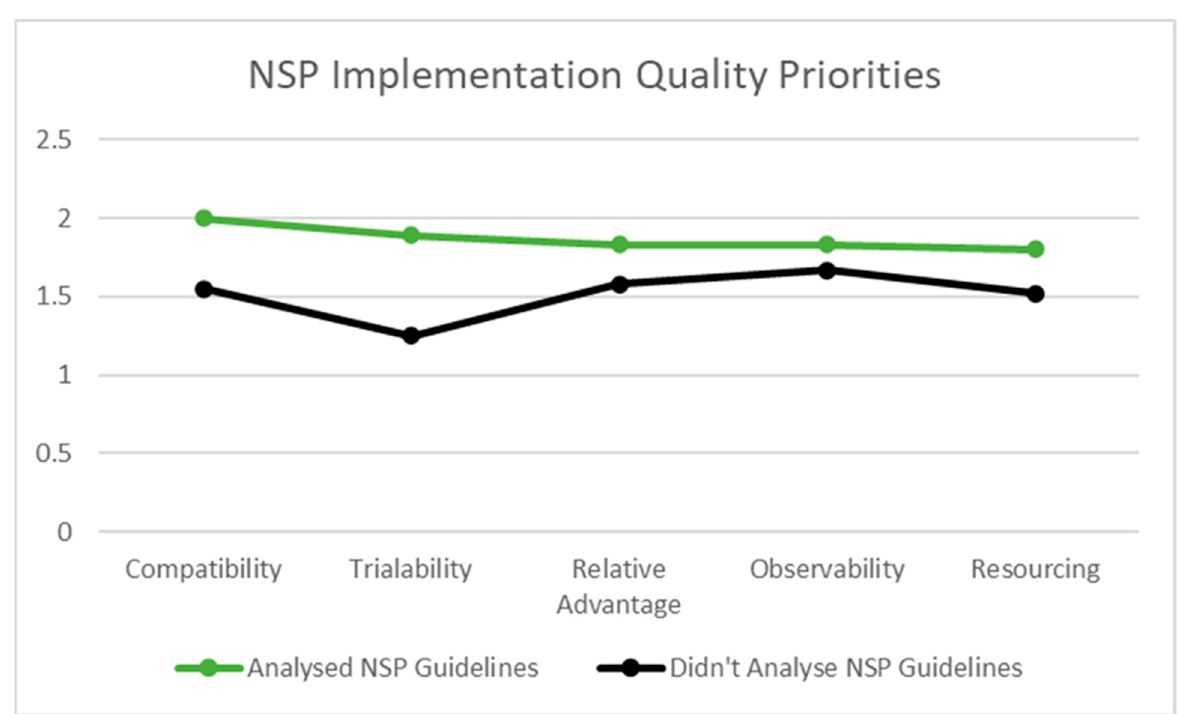
Figure 2. Implementation Quality Priorities of NSP Providers Who Have and Have not Analysed NSP